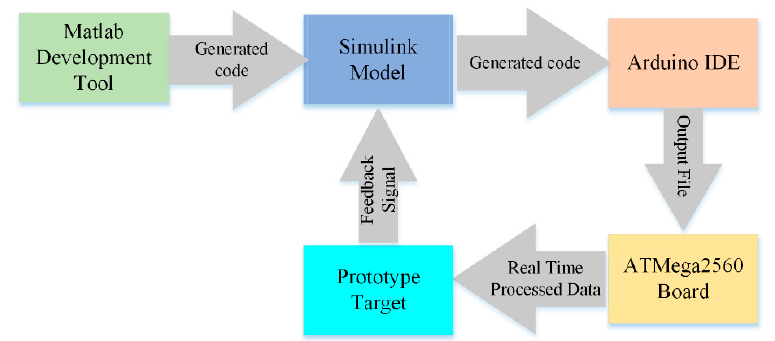
Figure 12. Integration of MATLAB-Arduino IDE code generation block diagram.